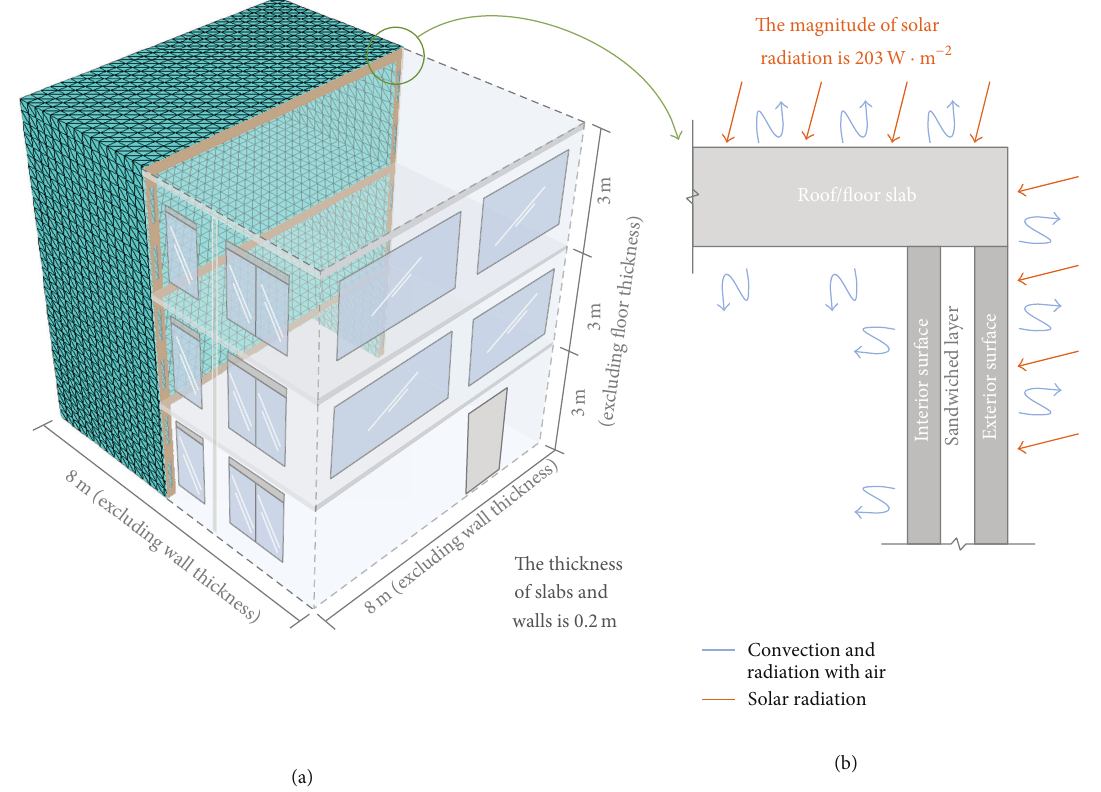
Figure 4: (a)The section view and the dimensions of a three-dimensional three-story building model (with meshing); (b) a two-dimensional schematic diagram showing the boundary conditions in the building model. The solar radiation is defined on exterior surfaces, while the convection and the radiation are defined on all surfaces which are in contact with air, including the exterior and interior surfaces.